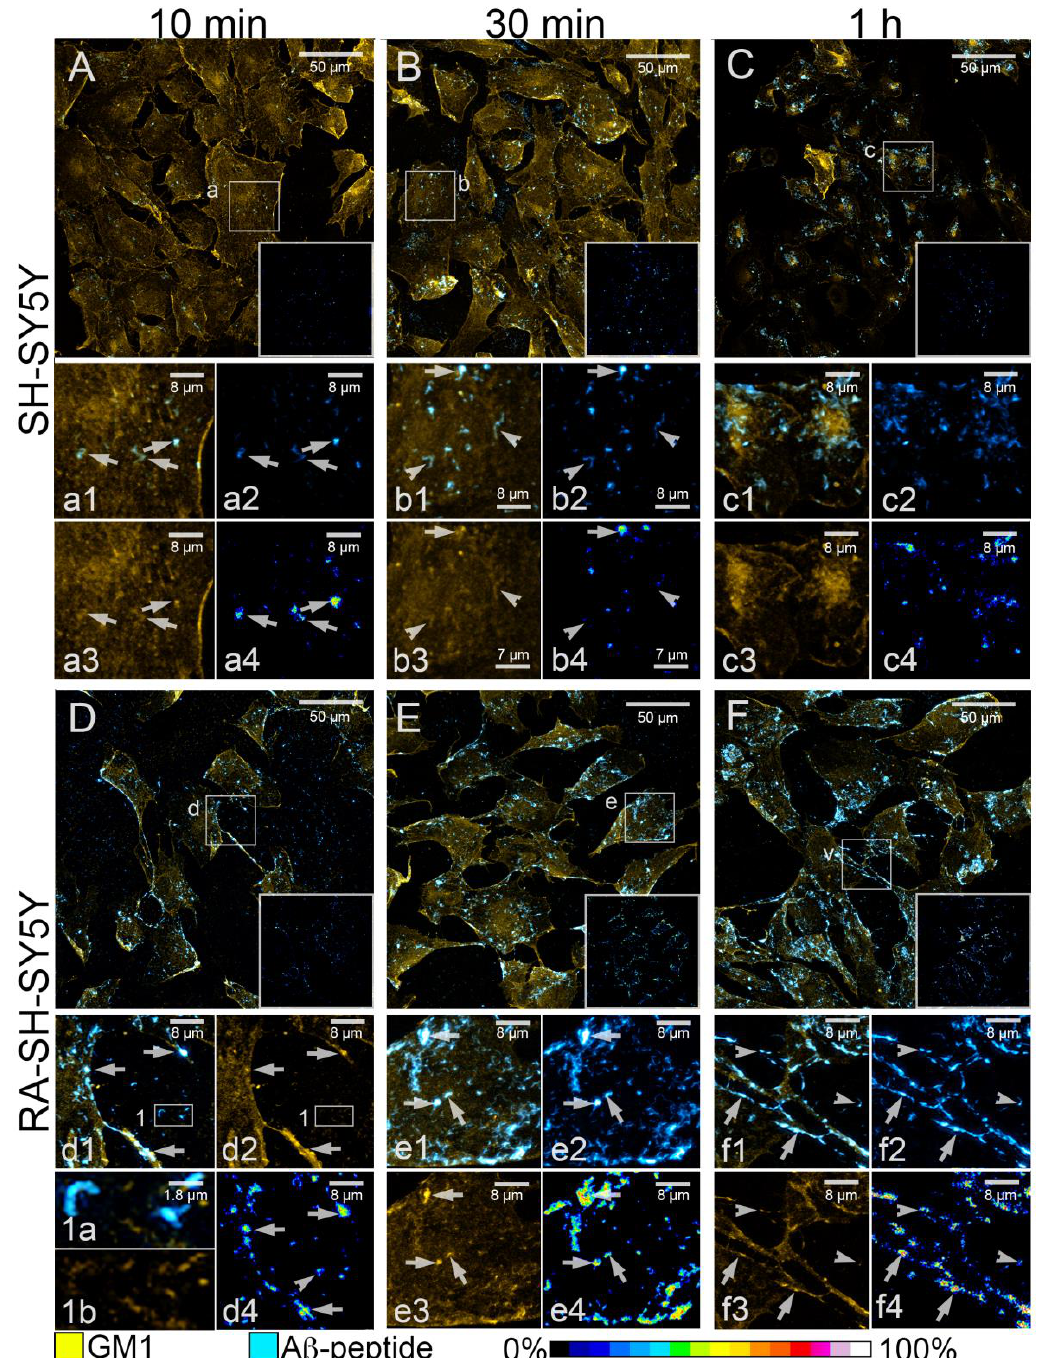
Figure 4. GM1 and A β -42 amyloid species in SH-SY5Y and RA-SH-SY5Y cells. ( A – F ) Representative images of SH-SY5Y ( A – C ) and RA-SH-SY5Y ( D – F ) cells stained to reveal GM1 (Yellow) after 10 min ( A , D ), 30 min ( B , E ) and 1 h ( C – F ) of incubation with A β -Fib (Cyan); square areas in lower right corner insets show efficiency of FRET interactions (corresponding full-size images are shown in Supplementary Figure S1). Insets ( a – e , v ) show details of the areas selected in images ( A – F ): images of merged channels ( a1 – f1 ), A β -42 immunofluorescence ( a2 – f2 ), GM1 staining ( a3 – c3 , e3 , f3 ) and FRET efficiency ( a4 – f4 ) are shown. Arrows in ( a – f ) indicate sites of high FRET efficiency between amyloid species and gangliosides. Arrowheads in ( a – c ) indicate sites of low FRET efficiency. Arrowheads in ( d – f ) indicate sites of amyloid binding to cell fragments on glass coverslips. Inset 1 shows details of the area selected in ( d) ; merged fluorescent signals ( 1a ) and GM1 staining alone ( 1b ) are